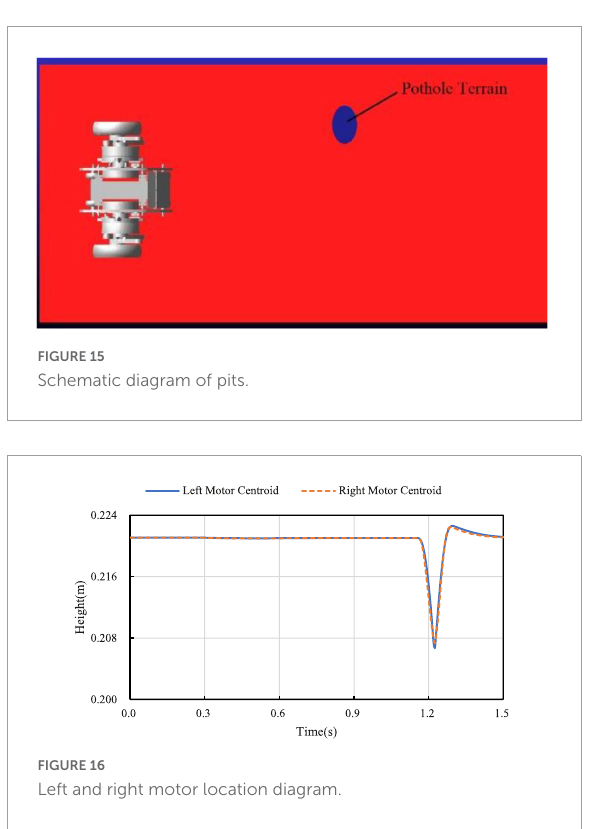
mode, and then reverts to the original posture through motors reversals. The simulation process is shown in Figure 10A . In order to realize the function of jumping over obstacles, the hip motors need to rotate with different steering to complete the contraction and extension of the wheel leg connecting rod, so as to storage and release the energy needed for jumping. Taking the single jump process of the robot as an example, its screenshot is shown in Figure 10B . When the robot moves at a constant speed of 1 m/s, the robot reaches the highest jump height of 0.16 m at 0.8 s. The take-off phase of the robot is 0.5–0.6 s, the flight phase is 0.6–0.95 s, and the landing phase is 0.95–1.2 s.